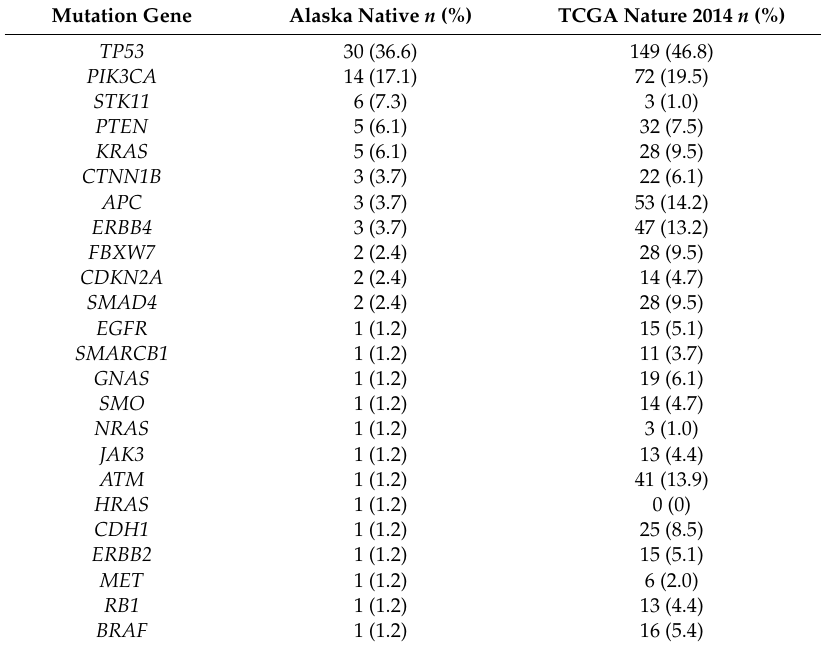
Table 2. Frequent single nucleotide variant (SNV) gene alterations.